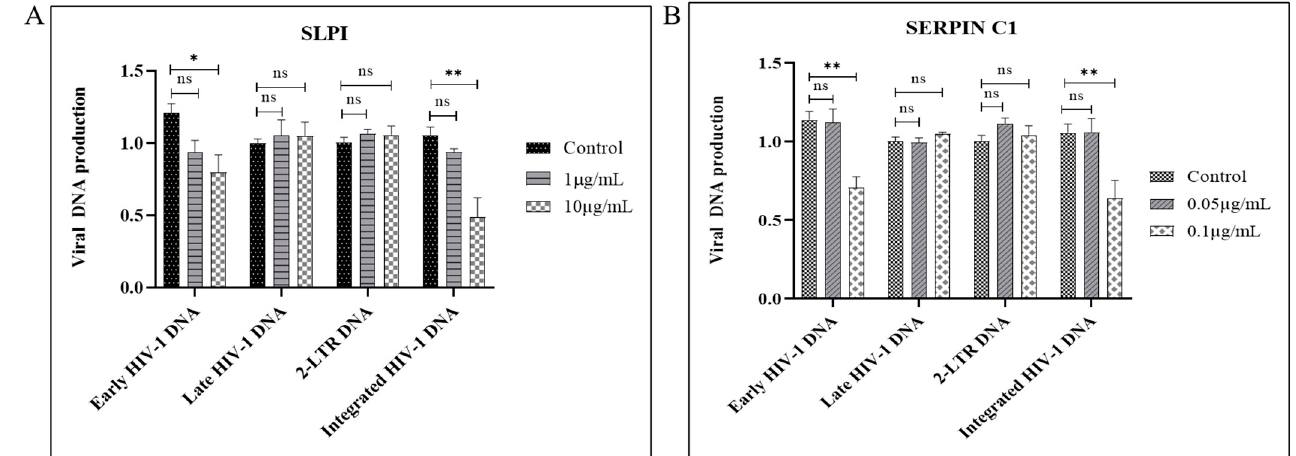
Figure 4. Modulation of early and integrated HIV-1 DNA production by SLPI ( A ) or SERPIN C1 ( B ); MDMs (5 × 10 5 cells/well) were pre-treated with ( A ) SLPI 1 μ g/mL and 10 μ g/mL or ( B ) SERPIN C1 0.05 μ g/mL and 0.1 μ g/mL for 3 h then infected with HIV-1 BaL 5 ng/mL p24 units. After 2 h, the virus was removed, and fresh culture media added with 1 μ g/mL and 10 μ g/mL SLPI or 0.05 μ g/mL and 0.1 μ g/mL SERPIN C1 and cultured. MDMs were collected 16 h after infection, and total DNA was extracted with the DNeasy tissue kit. Real-time PCR was performed with equal amounts of DNA and measured the amounts of early and late reverse transcription DNA products, as well as 2-LTR circle DNA. Levels of integrated viral DNA were measured by Alu-PCR. Effect of SLPI and SERPIN C1 on HIV-1 DNA production was determined by calculating the ratios of viral DNA amounts produced without SLPI or SERPIN C1 versus treatment with SLPI or SERPIN C1 in MDMs. Results expressed as mean ± SEM from three independent donors. Asterisk (*) over the bars indicates significant difference with control, ** p < 0.001; * p ≤ 0.05 and ns p > 0.05. p -values were generated by one-way ANOVA with multiple comparisons.